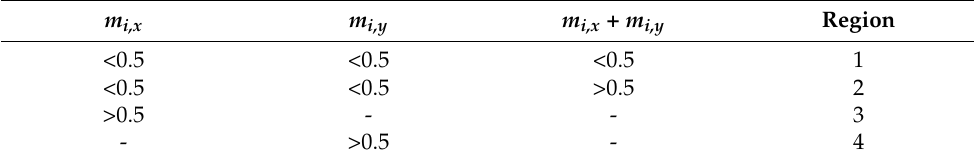
Table 2. Region decision.